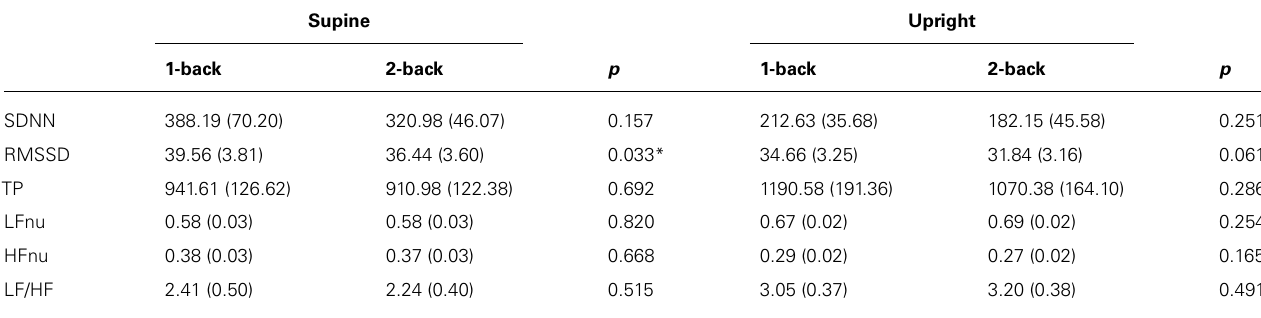
Table 3 | Means and standard errors of HRV parameters of posture and work load